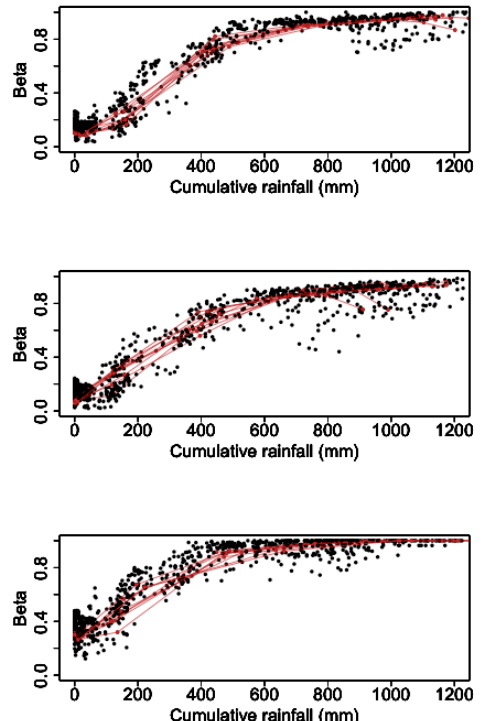
Figure 5. Cumulative precipitation (November to March) versus the JULES beta parameter for (from top to bottom) Chikanta, Magoye, and Makafu. The brown dots and lines highlight one year (May 2004) during which were severe agricultural losses in Zambia.